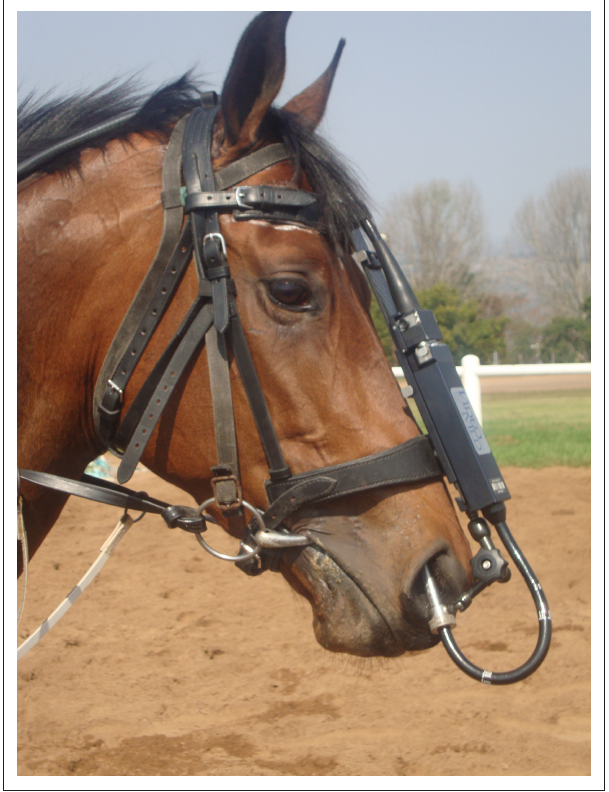
FIGURE 2: Endoscope in position prior to